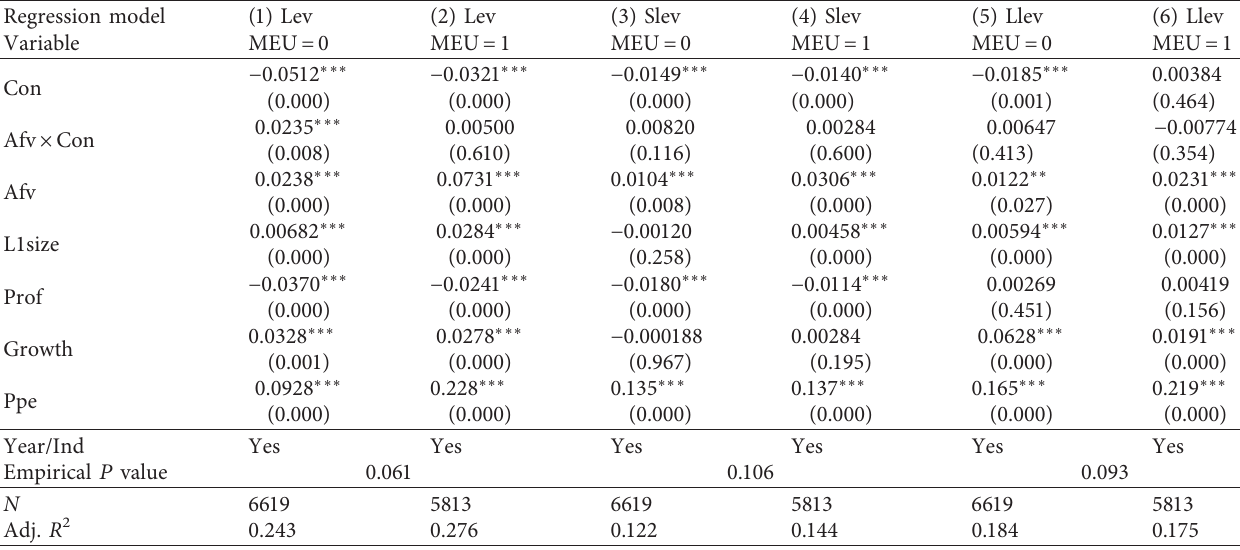
Table 8: The influence of environmental uncertainty on the adjustment of fair value